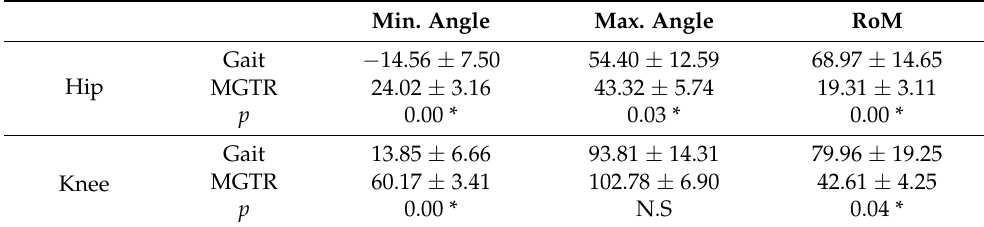
Table 2. Results of the kinematic data.